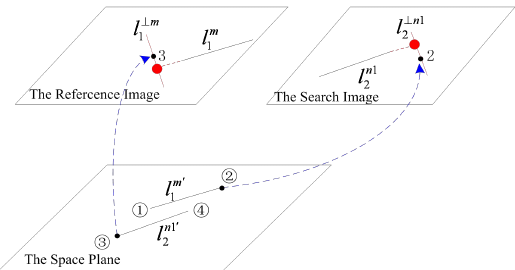
Fig.6 Determination of endpoints for corresponding lines